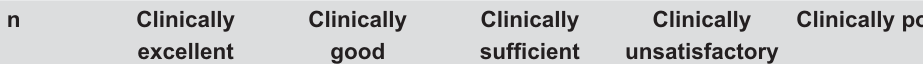
Table 4- One-year clinical evaluation of restorations: biological n